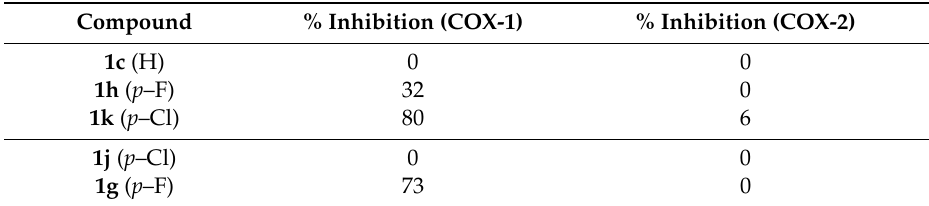
Table 6. Predicted Energy and IC 50 values and in vitro activity of synthesized compounds against COX-1 / 2 1 . Experimental IC 50 , µ M